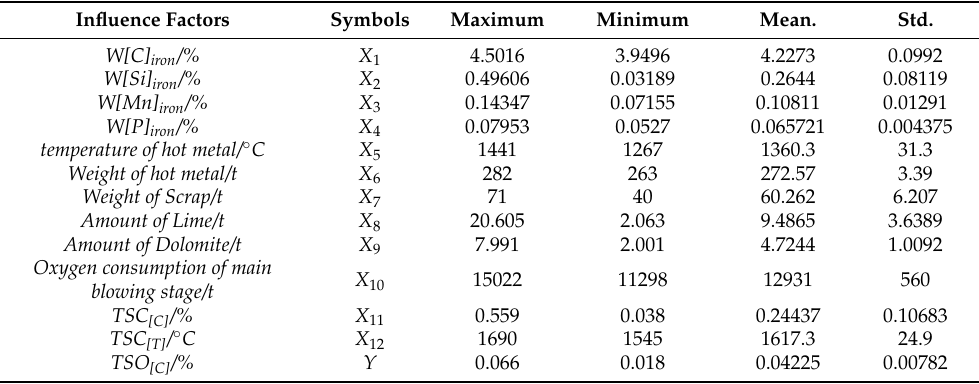
Table 1. Statistical results of influencing factors of single-value